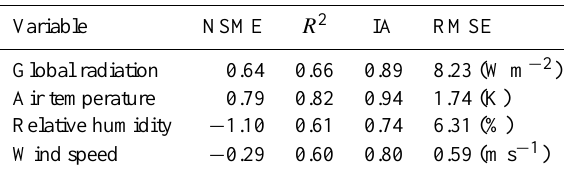
Table 1. Performance of ESCIMO.spread (v2) in the modification of outside-canopy global radiation, temperature, relative humidity and wind speed for canopy